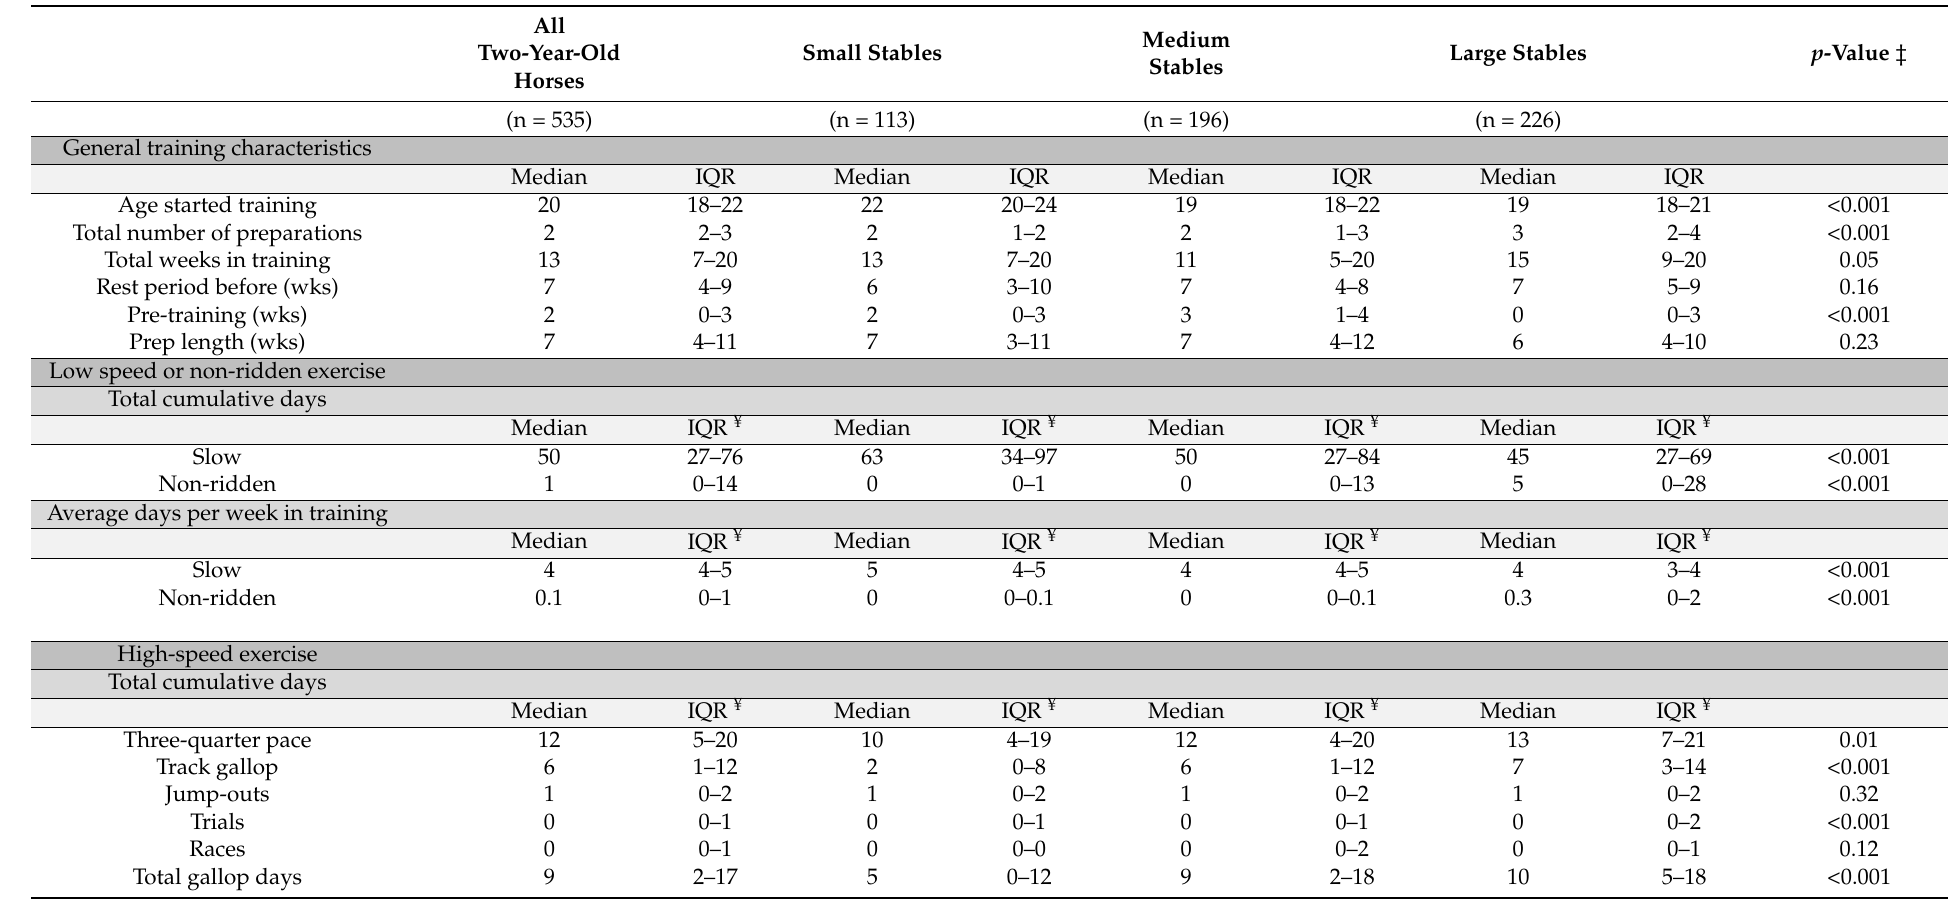
Table A1. Overall summary training and racing statistics for two-year-old horses in Queensland, Australia. All Small Horses